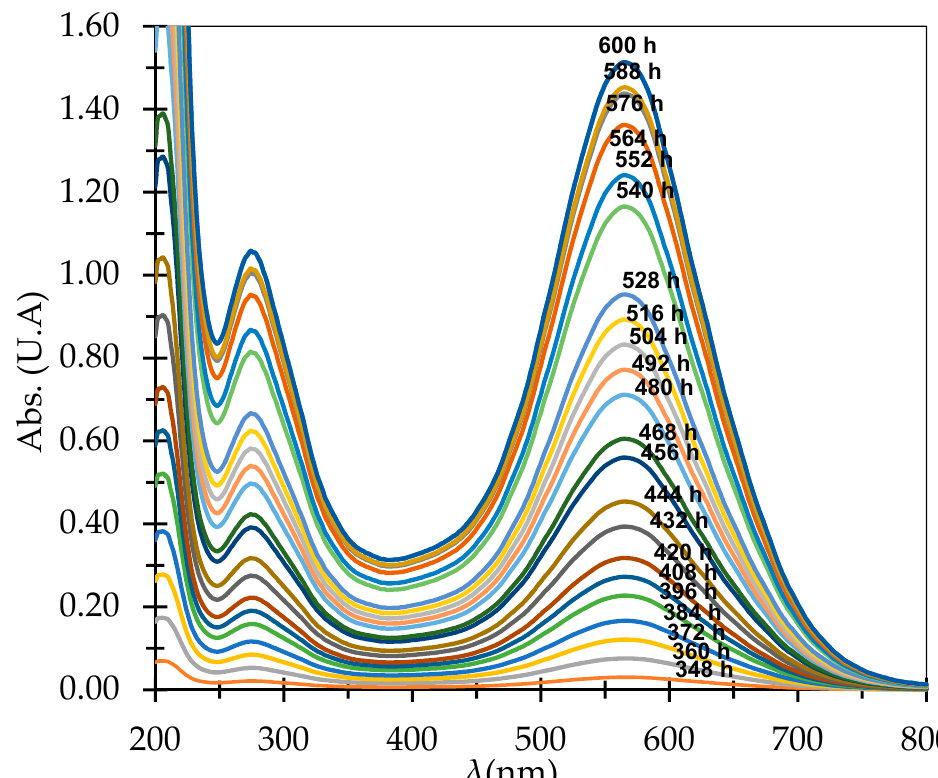
Figure 8. Graphical representation of AB 113 dye existing in outflow samples. Figure 8. UV-Vis spectra of AB 113 dye existing in outflow samples.